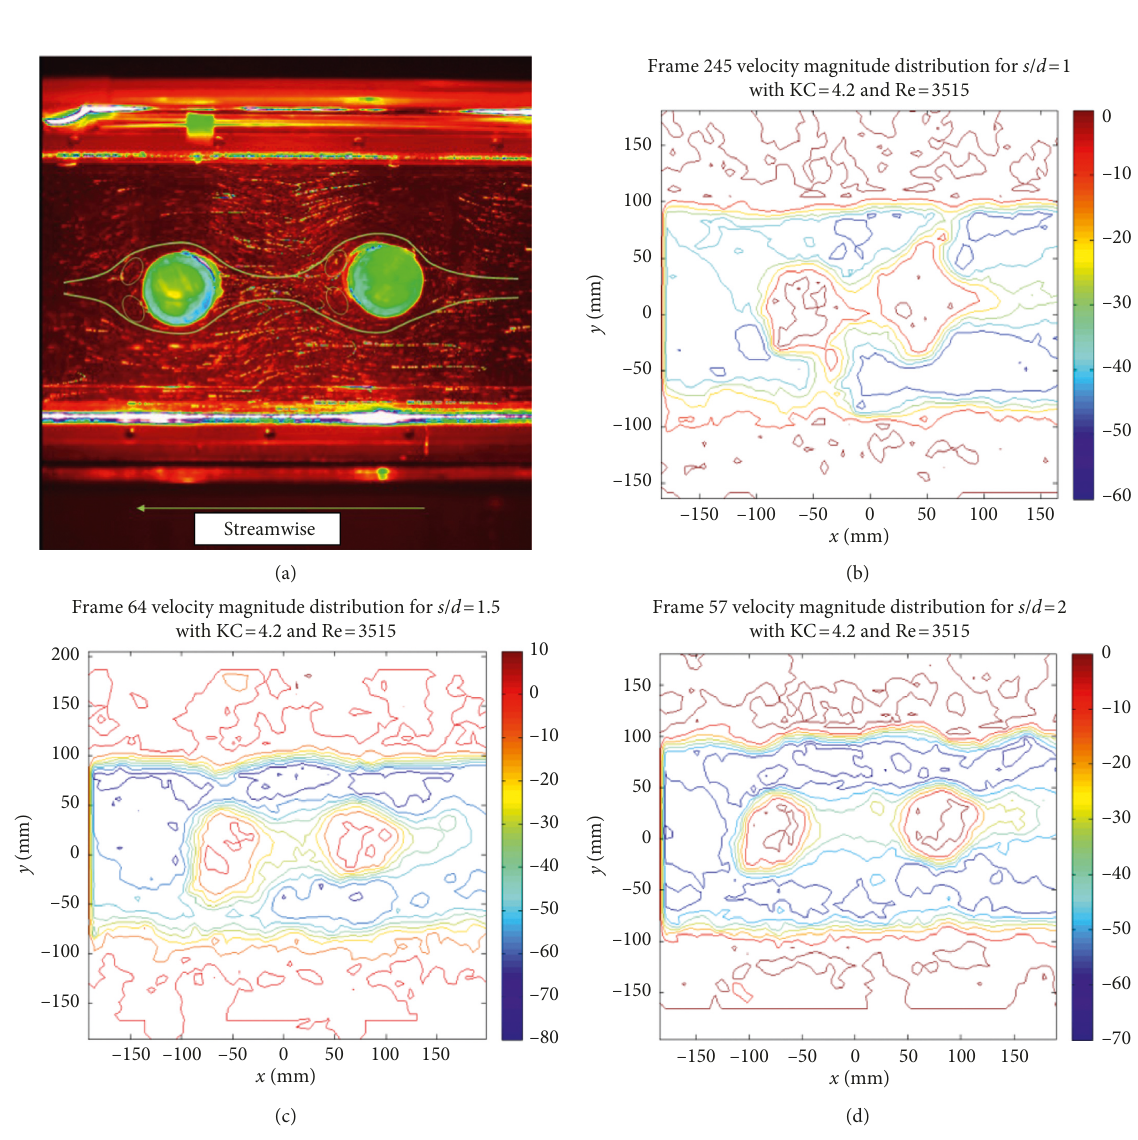
Figure 6: Outputs for KC � 4.2, (a) streaks for KC � 4.2 and Re � 3515.1 with spacing of 2, (b) horizontal velocity contours for s/d � 1, (c) horizontal velocity contours for s/d � 1.5, and (d) horizontal velocity contours for s/d �